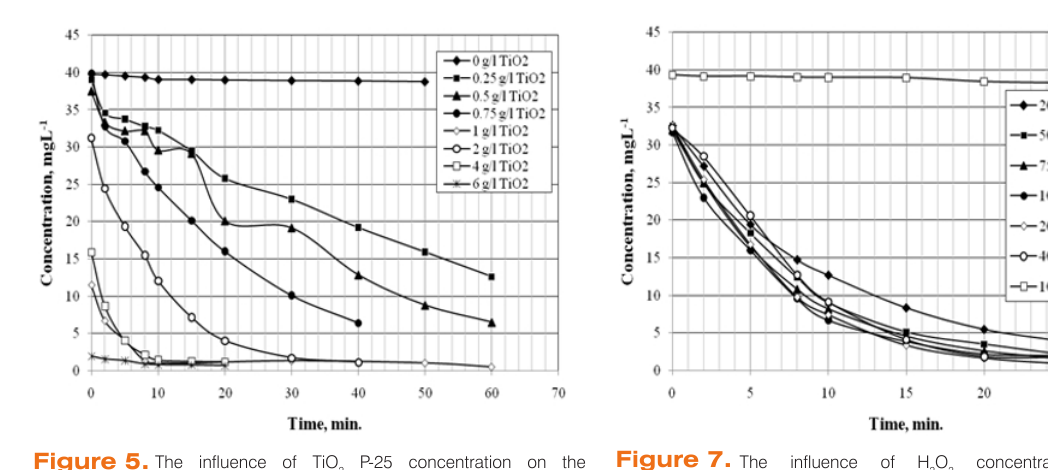
O concentration on the 2 2